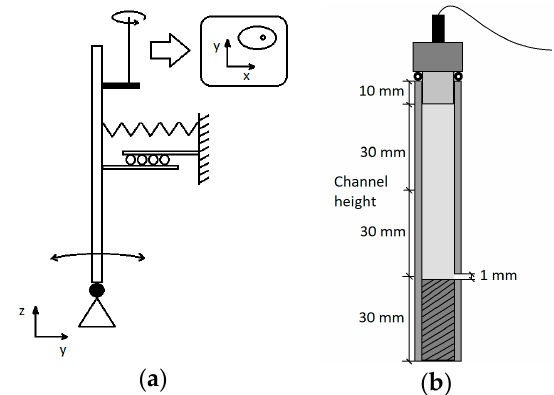
Figure 3. Tubes experimental set up ( a ) Forced vibration mechanism for the vibrating tube ( b ) pressure transducers location in the monitored tubes.